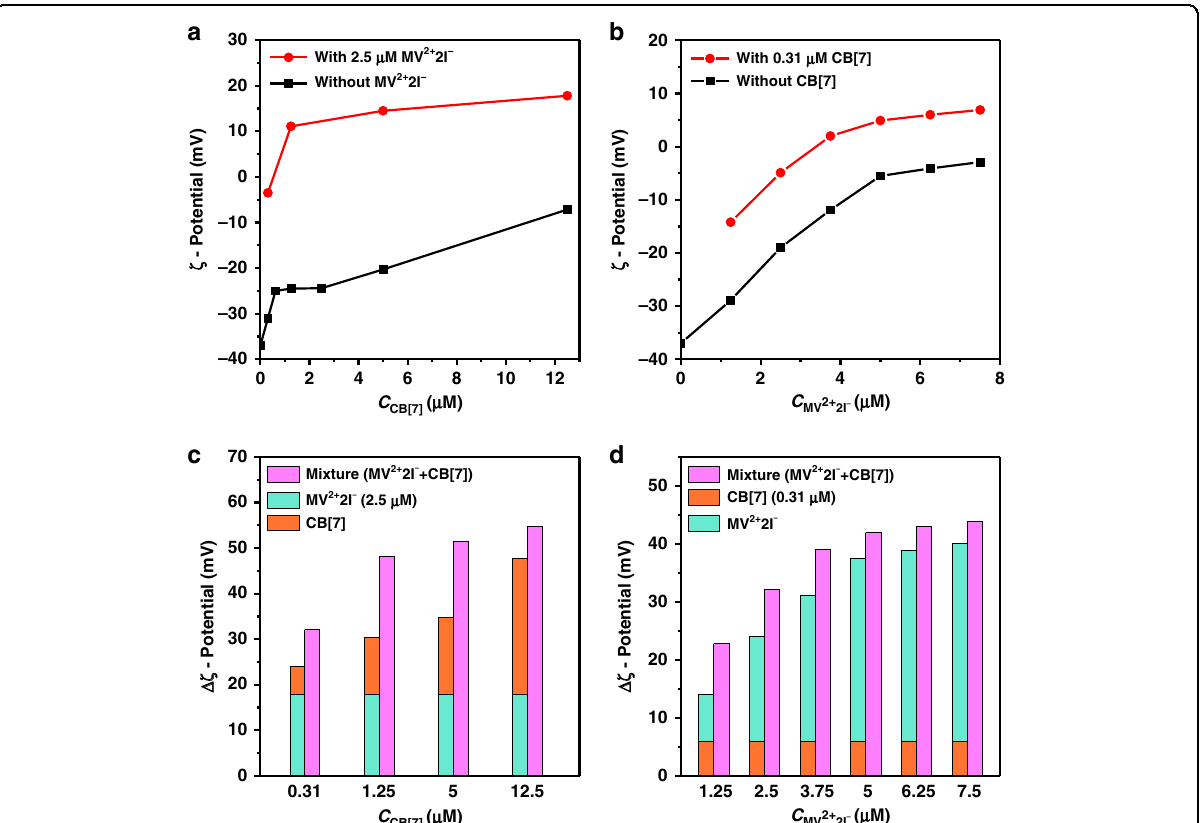
Fig. 2 ζ -potential variations on the addition of host and/or guest solutions. a CB[7] concentration-dependent ζ -potential of Au NPs colloid with (red line) and without (black line) 2.5 μ M MV 2 + 2I − . b MV 2 + 2I − concentration-dependent ζ -potential of Au NPs colloid with (red line) and without (black line) 0.31 μ M CB[7]. c and d Pink columns show the variations in ζ -potential ( Δζ mix ) with simultaneous additions of CB[7] and MV 2 + 2I − . Orange and green columns display the sum in variations of ζ -potential ( Δζ sum ) caused solely by CB[7] and MV 2 + 2I